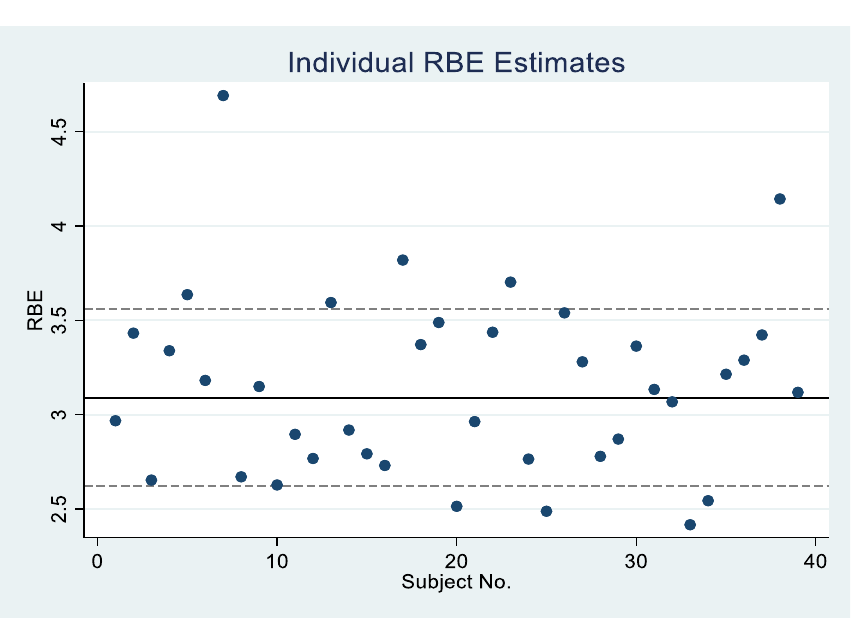
Figure 5. Individual RBE estimates. The RBE for an average subject is represented by the horizontal line with 95% confidence limits (dashed lines). Subject numbers were assigned randomly to preserve sensitive personal